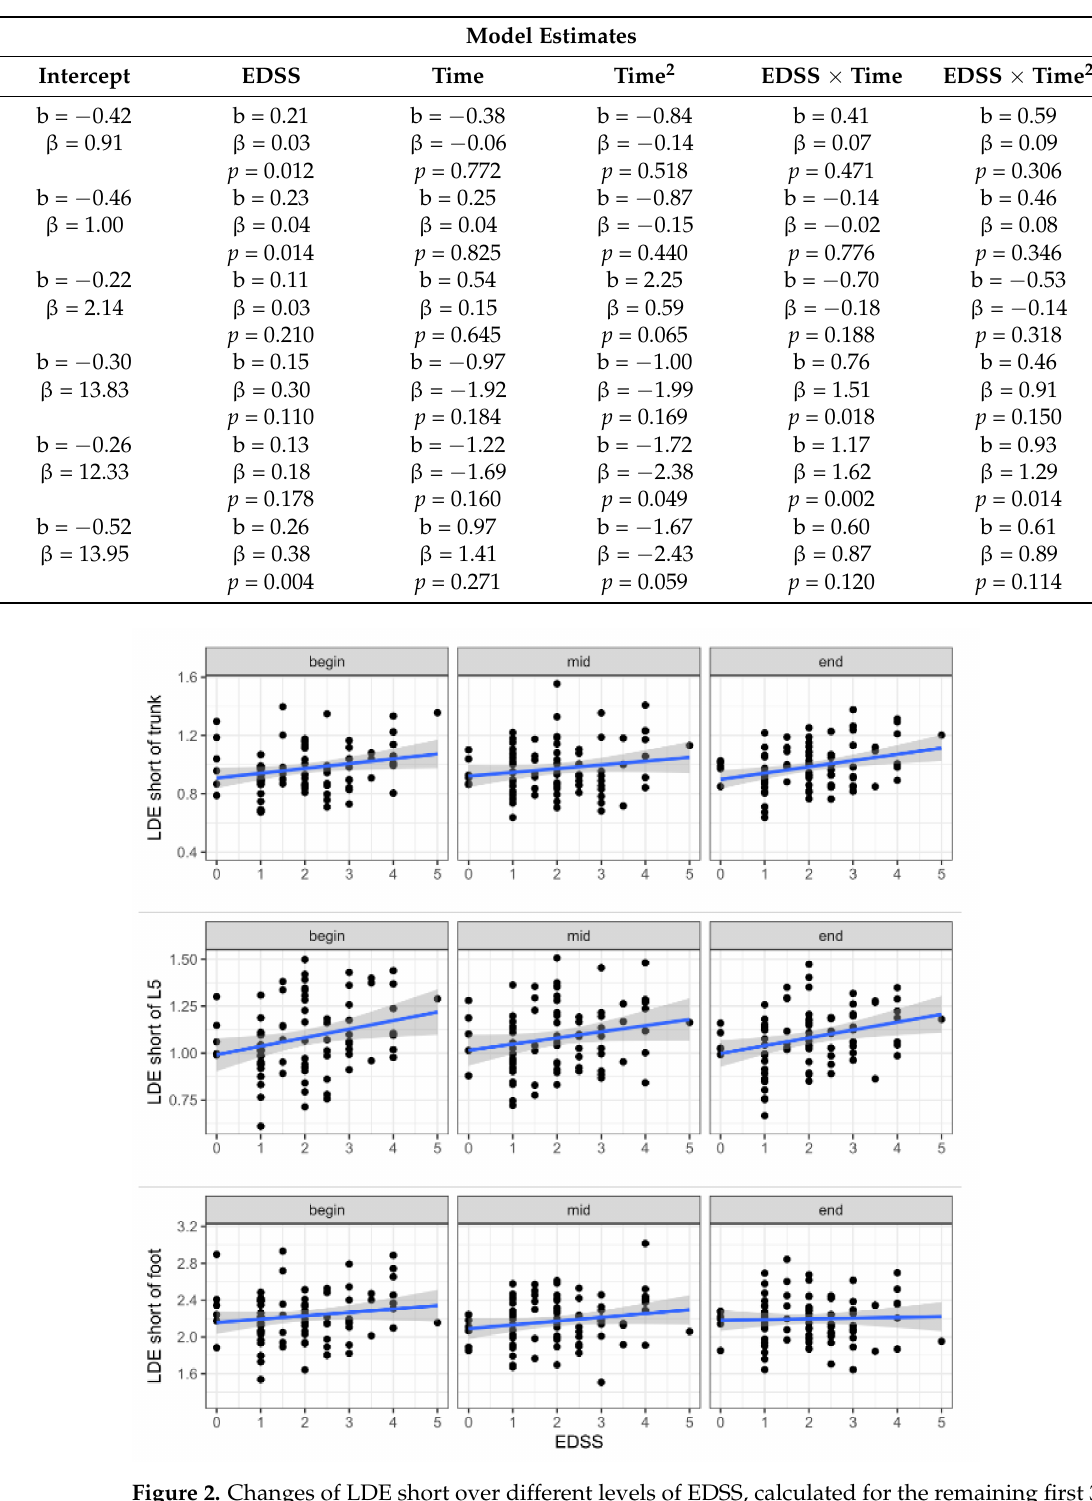
Figure 2. Changes of LDE short over different levels of EDSS, calculated for the remaining first 30 (begin), middle 30 (mid) and last 30 strides (end) during a 6-min 25-ft walk and separated for the foot, lumbar spine (L5), and trunk